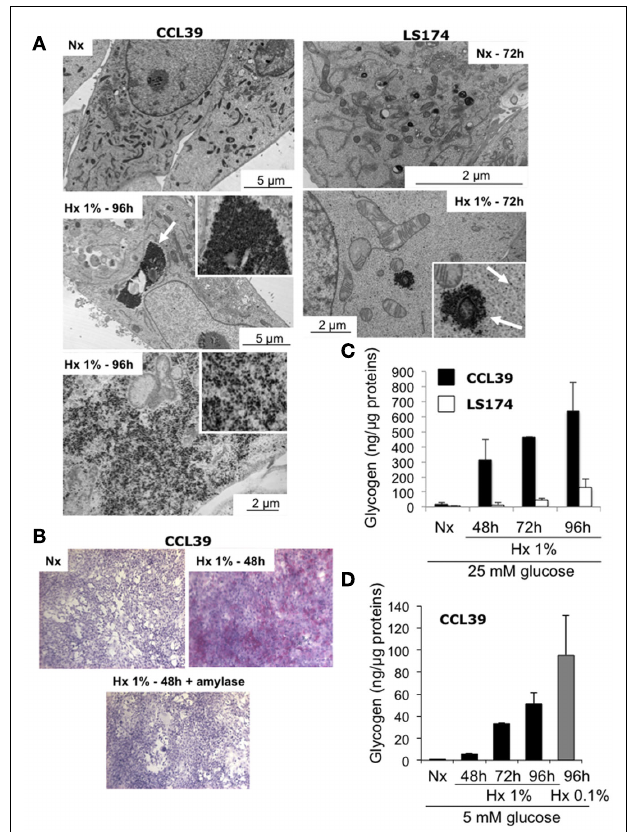
FIGURE 1 |Accumulation of glycogen in hypoxia in non-cancer and cancer cells. (A) Electron micrographs of CCL39 (left panel), LS174 (top right panel), and HeLa (bottom right panel) cells in normoxia (Nx – 72h) and hypoxia 1% O 2 (Hx 1% – 72 or 96h). Arrows denote aggregates of glycogen particles in CCL39 and LS174 cells. (B) PAS staining of CCL39 and LS174 cells exposed to normoxia (Nx) and hypoxia (Hx) for 96h. (C) Quantification of the amount of glycogen in CCL39 (black bars) and LS174 (white bars) cells grown in normoxia (Nx) or hypoxia 1% O 2 (Hx 1%) for 48, 72, and 96h in a 25-mM glucose-containing medium. (D) Quantification of the amount of glycogen in CCL39 cells grown in normoxia (Nx) and hypoxia 1% O 2 (Hx 1%) for 48, 72, or 96h (black bars) and hypoxia 0.1% O 2 (Hx 0.1% – gray bar) in a 5-mM glucose-containing medium. Data represent the average of at least three independent